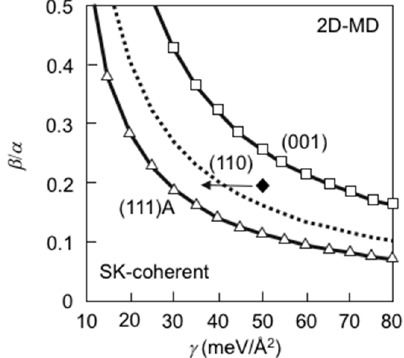
Figure 13. Calculated growth mode boundaries as functions of β / α and γ for the InAs/GaAs systems with different orientations. Open square and open triangle denote the results for the (001)- and the (111)A-oriented InAs/GaAs, respectively. The growth mode boundary (dotted line) and the data (closed diamond) for the InAs/GaAs(110) are also shown in this figure.